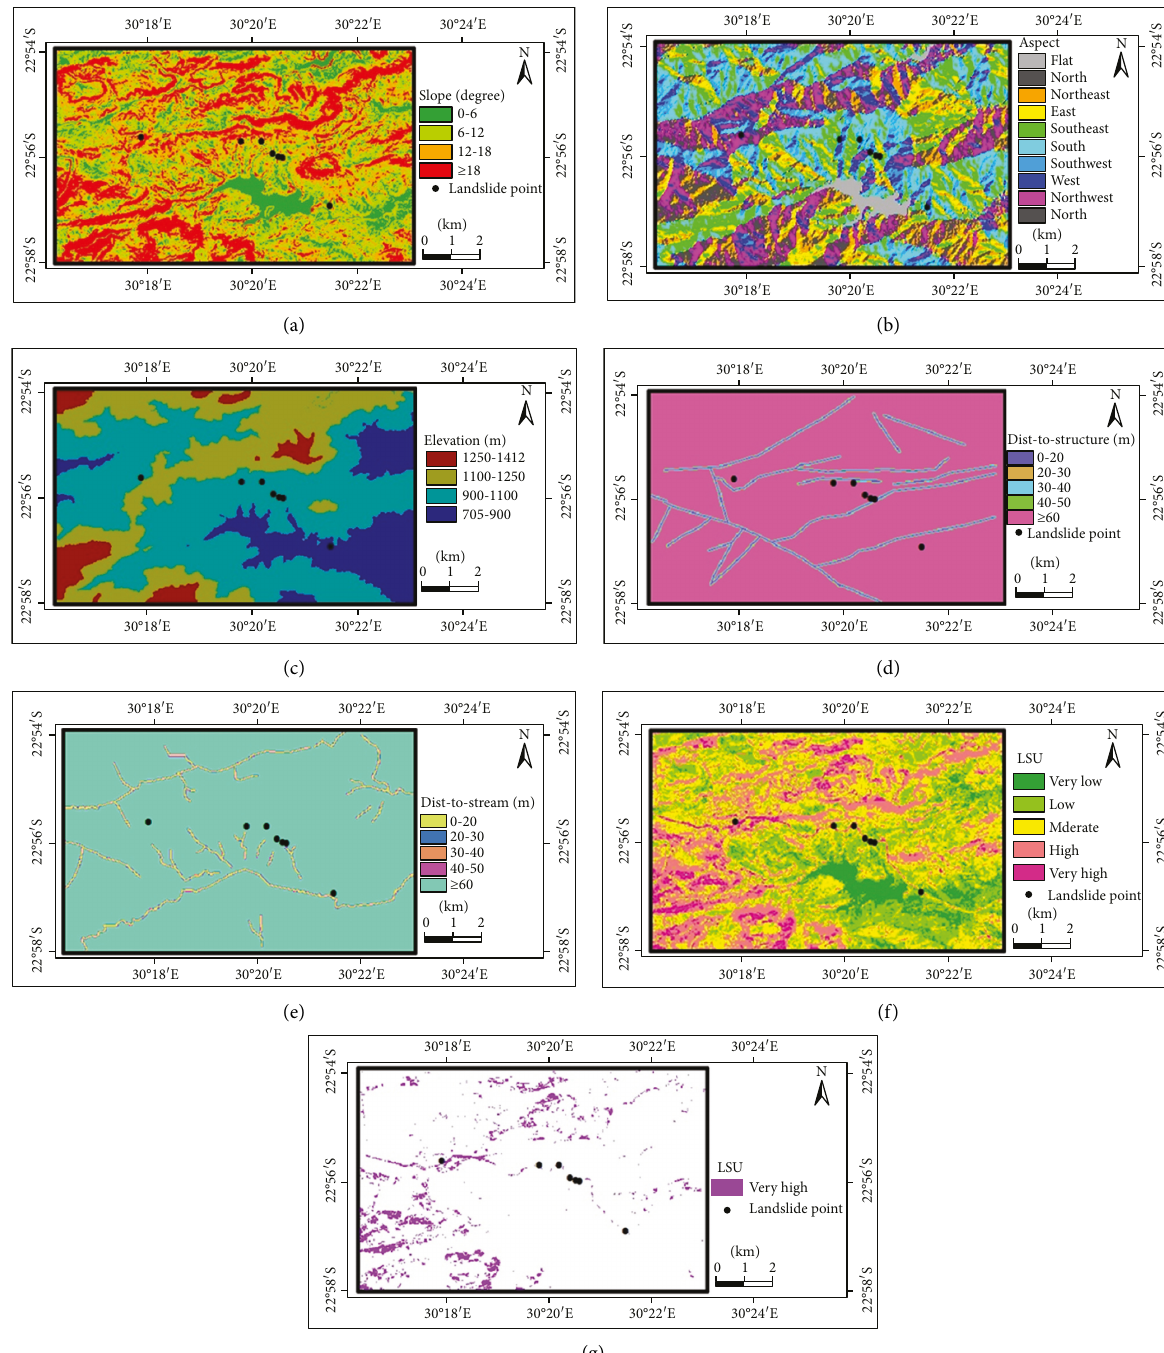
Figure 3: (a) Slope angle simulated throughout the study area. (b) Slope orientations. (c) Elevation in the vicinity of the study area. (d) Locations of slope instability relative to geological structures. (e) Location of slope instability relative to water streams. (f) Slope stability susceptibility map of the study area. (g) High-risk zones of slope instability. Note that the term landslide is used as an interchange word of slope